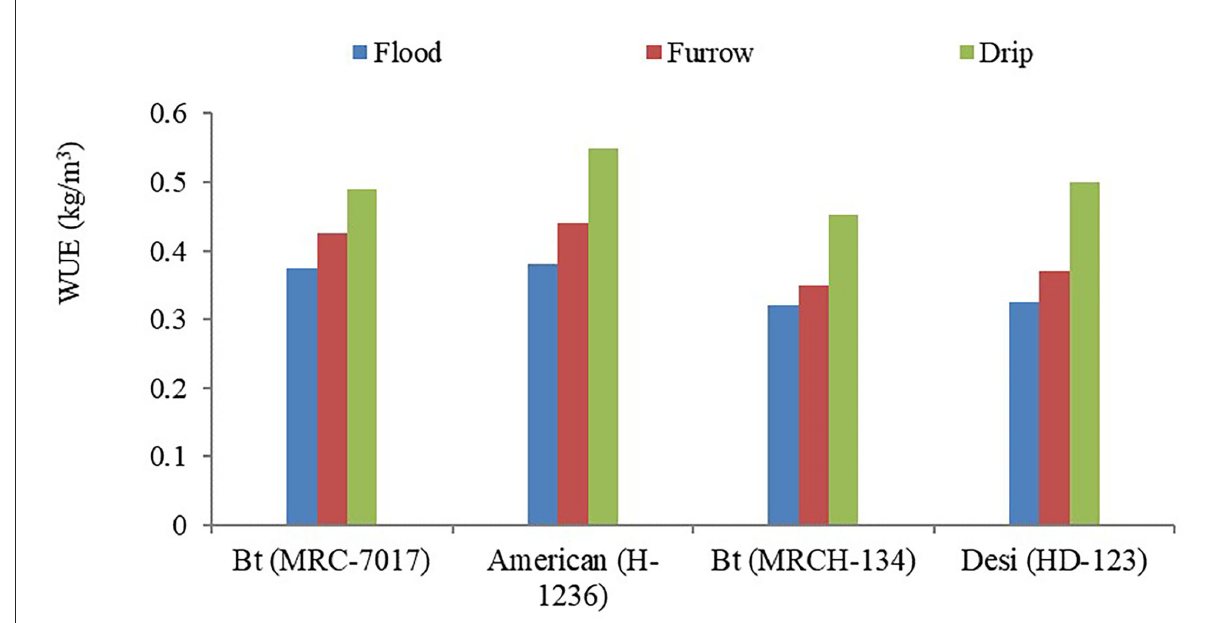
FIGURE12 Effect of irrigation methods on WUE of different cotton cultivars. Adapted from Choudhary et al. (2016).